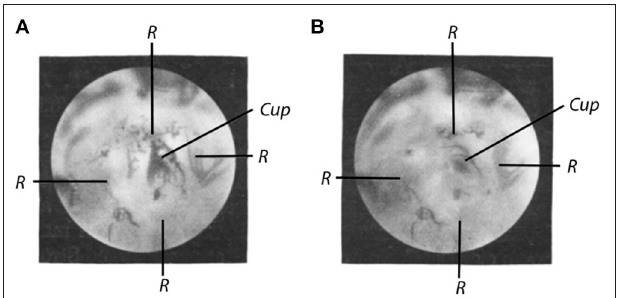
FIGURE 1 | (A) Ampulla of the anterior semicircular canal of the pike with incised window in which the cupula ( Cup ) can be seen. R = edges of the window. Freshly-produced preparation. The dark areas are Chinese ink particles. Lateral slit lamp illumination. Image captured on May 30, 1927 at 5.30. Beginning of the dissection at 2.10. Exposure time 9min (to obtain the best possible depth effect, the exposure was set to 3min, respectively, at 3 different depths). Objective Leitz 3. Ocular Leitz 1. Magnification 50x (Image number 30) (B) . Same preparation. Cupula in motion (cf. text). Captured at 5.00, otherwise as (A) (Image number